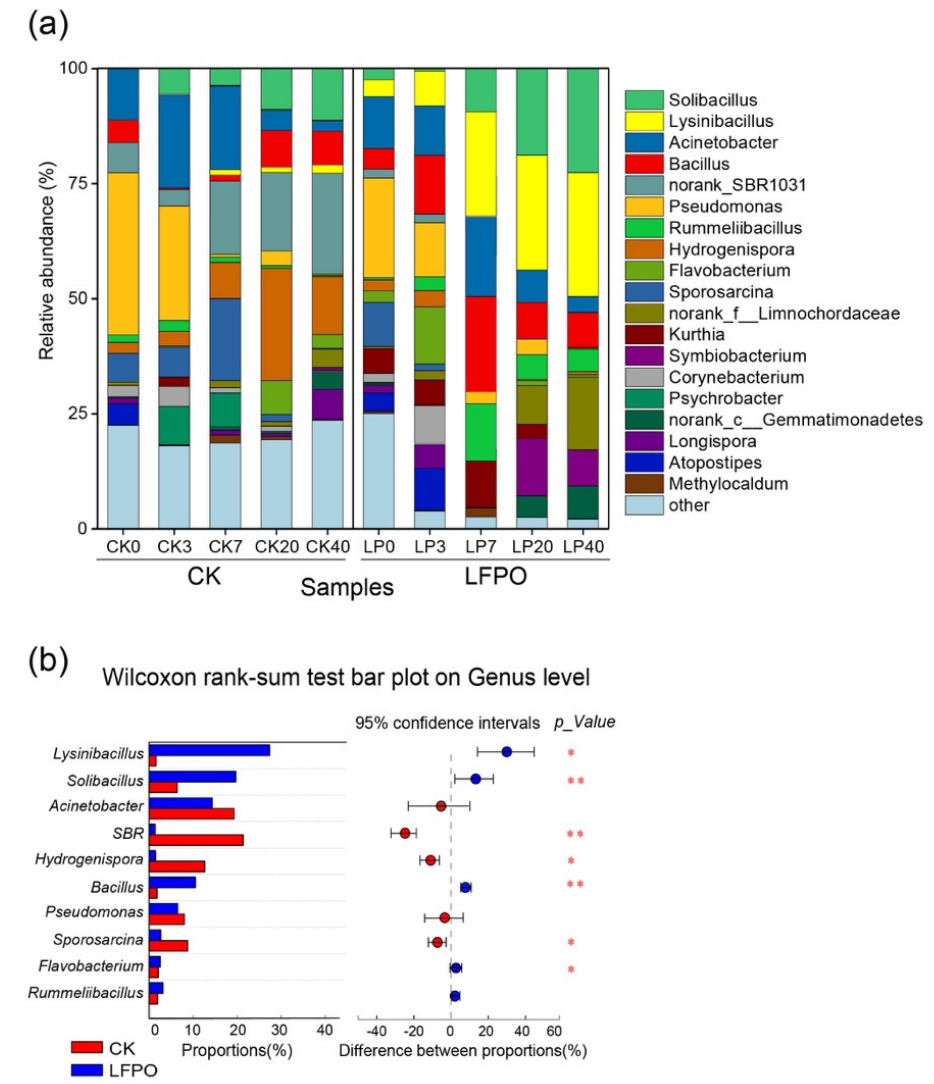
Figure 2. The bacterial community structures in cow manure and wheat straw compost with and without inoculation. ( a ) The bacterial taxa at the genus level; taxa with <1% reads were combined as “others”. ( b ) Wilcoxon rank-sum analysis of significant bacterial genera between silages without and with inoculation; **, and * represent p < 0.01, and p < 0.05, respectively.